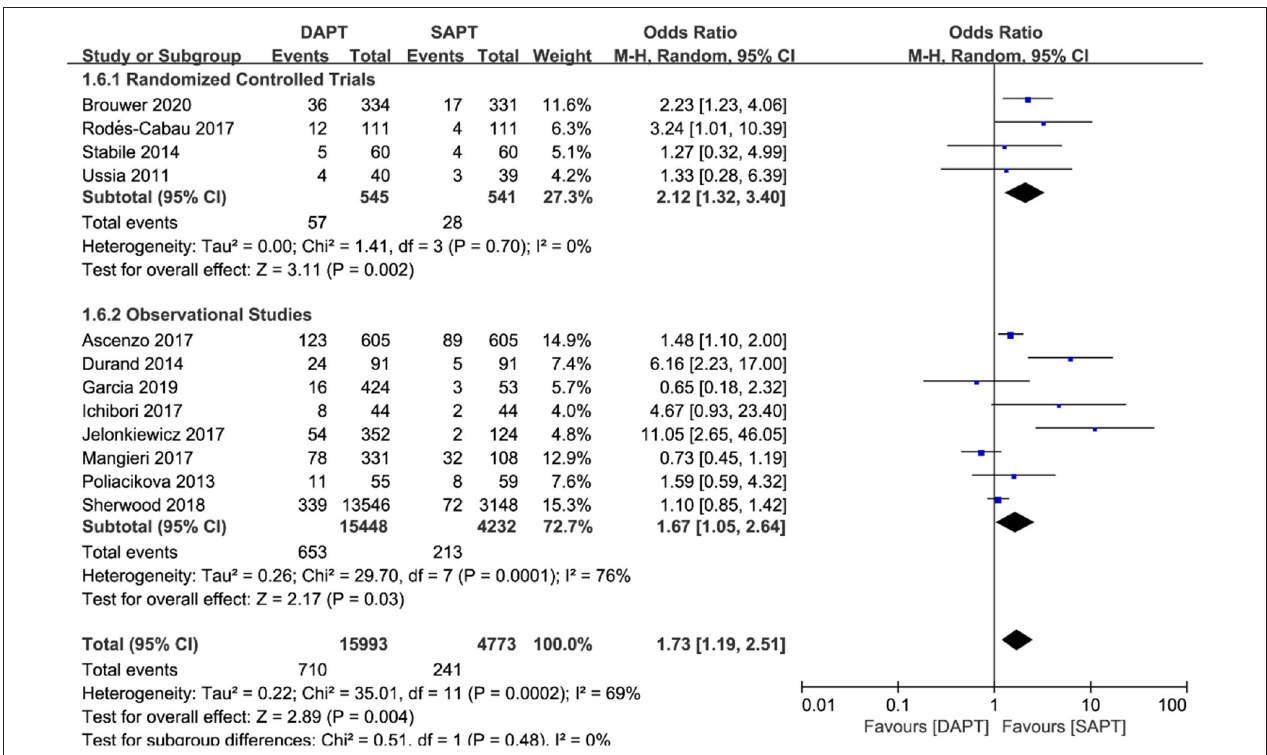
FIGURE 8 | Forest plot for major or life-threatening bleeding (LTB) with subgroup analysis stratified by study type at longest follow-up.